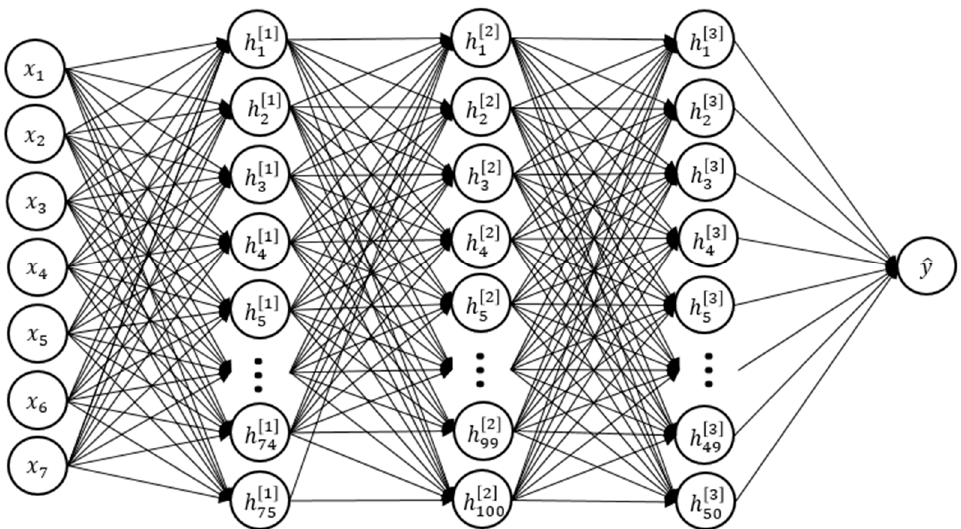
Figure 4. Configuration of a Deep Learning model.